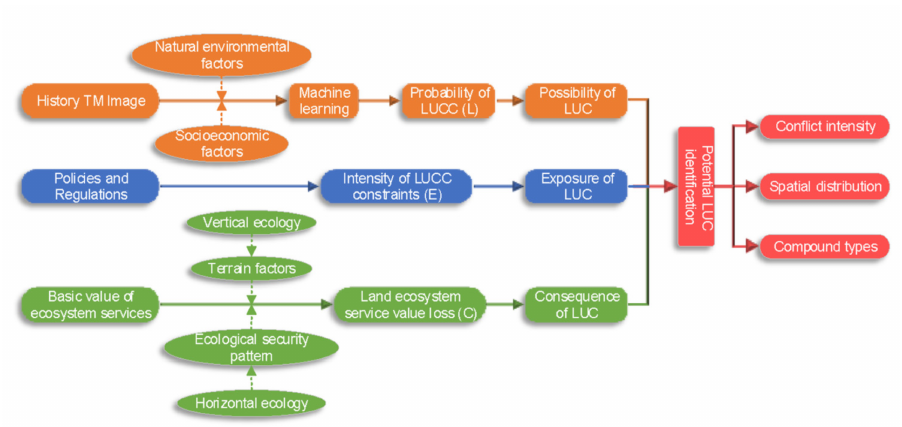
Figure 1. Analysis framework of the LUC identification